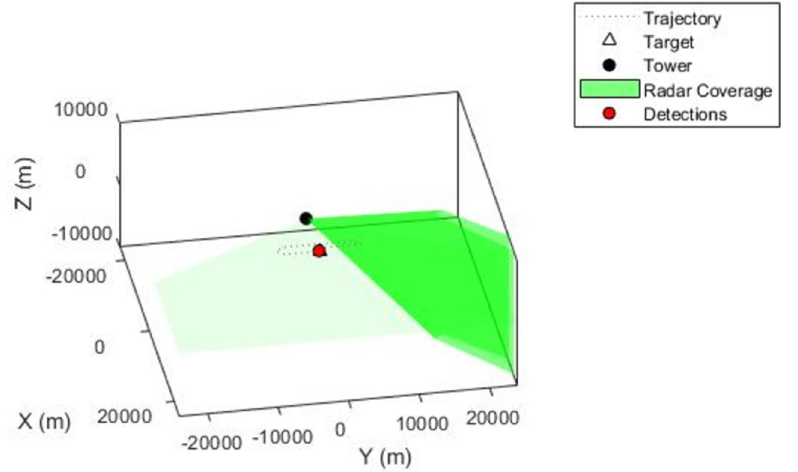
Fig 3. Plot of radar coverage mounted on 30m tower and signal detection of a moving drone.